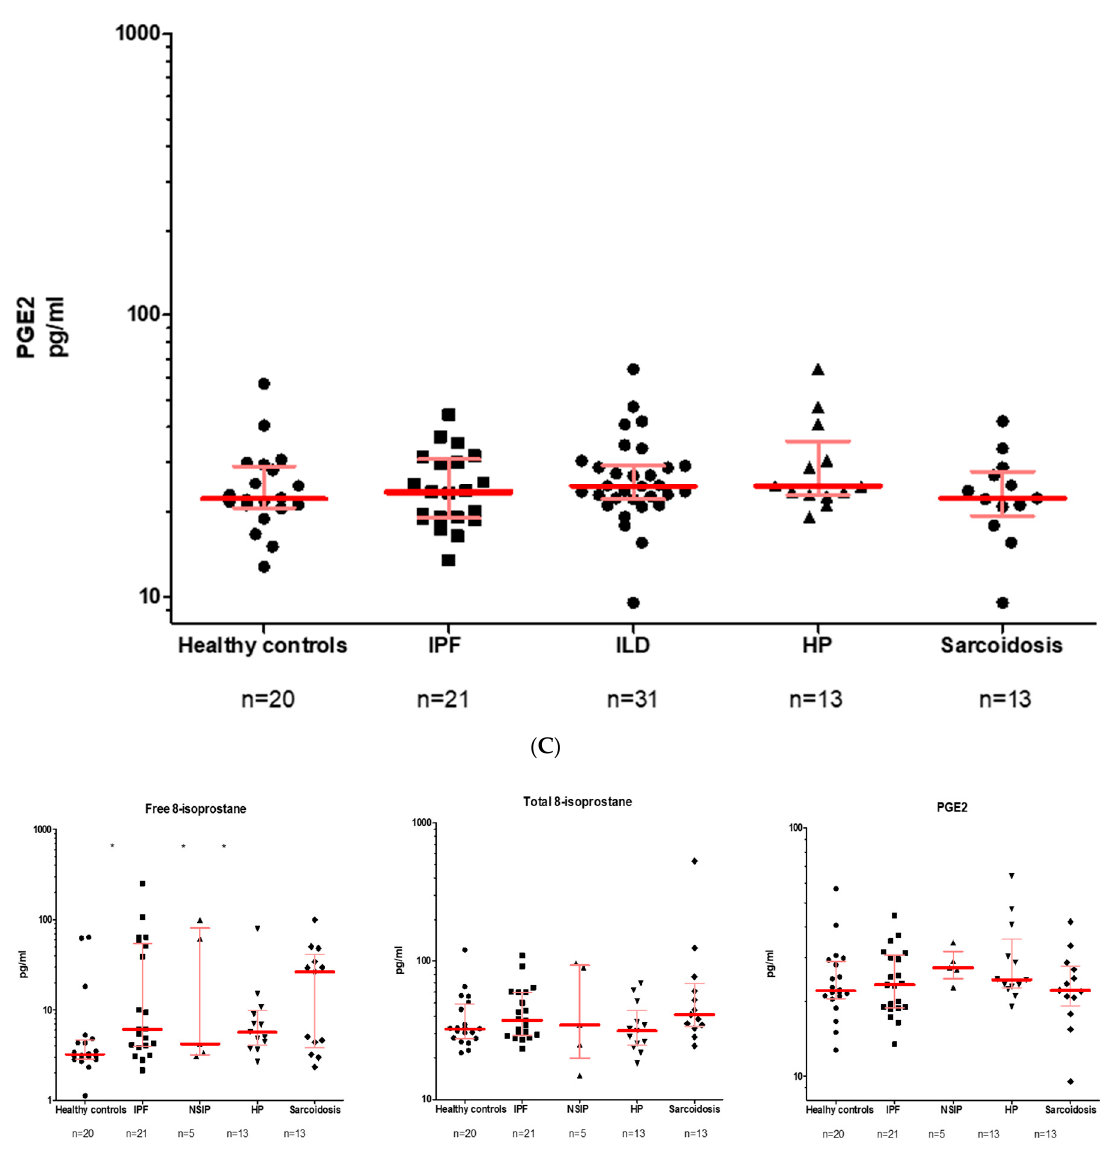
Figure 3. Distribution of PGE2 and 8-isoprostane in BALF. Data are given as median with interquartile range ( A ) Free 8-isoprostane ( B ) Total 8-isoprostane ( C ) PGE2 ( D ) ILD subgroup analysis in regard to all three above mentioned biomarkers. Abbreviations: IPF: idiopathic pulmonary fibrosis, ILD: interstitial lung diseases, NSIP: nonspecific idiopathic pneumonia, HP: hypersensitivity pneumonitis. If data not available from all patients, the number(s) is